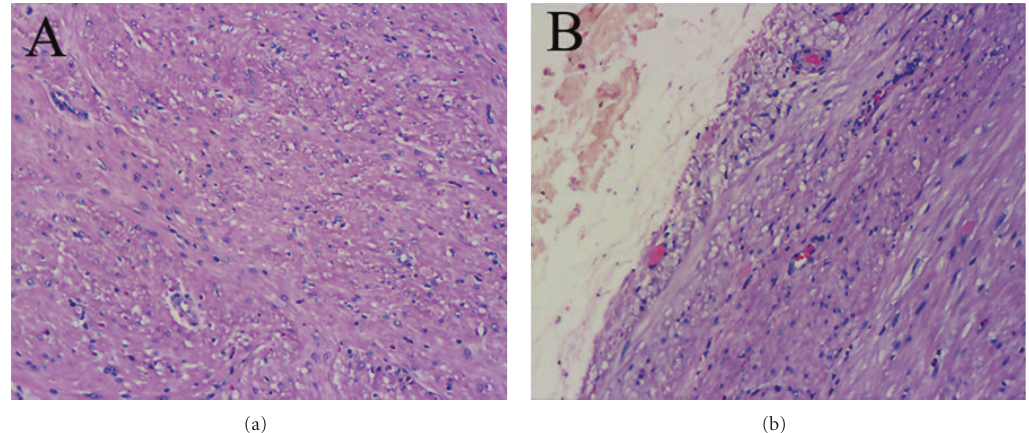
Figure 2: Pathology of the resected specimen. The pathology showed a leiomyoma (a) and clear margins (b) (magnifying × 200).